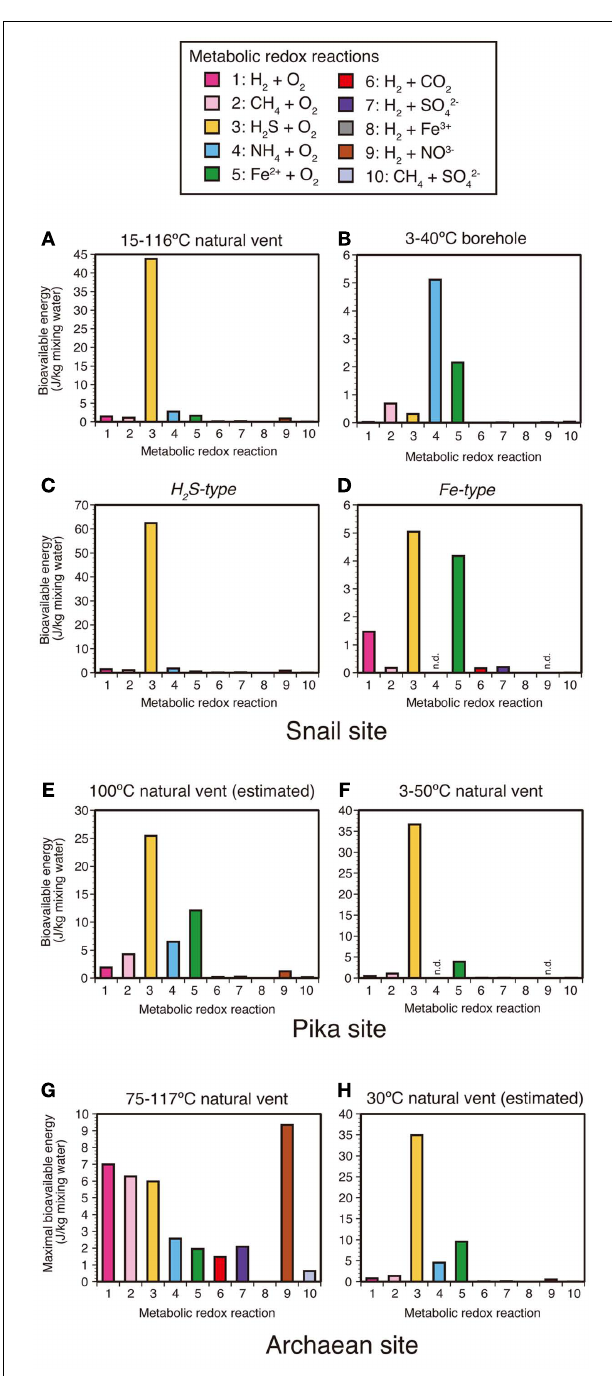
FIGURE 5 | Bioavailable energy yields for metabolic redox reactions for each sample type. For the Snail site, the energy yields result from (A) 15–116˚C natural vent, (B) 3–40˚C borehole, (C) H 2 S-type, and (D) Fe-type fluids. For the Pika site, the energy yields result from (E) 100˚C natural vent and (F) 3–50˚C natural vent fluids. For the Archaean site, the energy yields result from (G) 75–117˚C natural vent and (H) 30˚C natural vent fluids.The bioavailable energy yields for (E) 100˚C natural vent in the Pika site and for (H) 30˚C natural vent in the Archaean site were calculated using the geochemical data estimated from a simple mixing model of hydrothermal fluids and